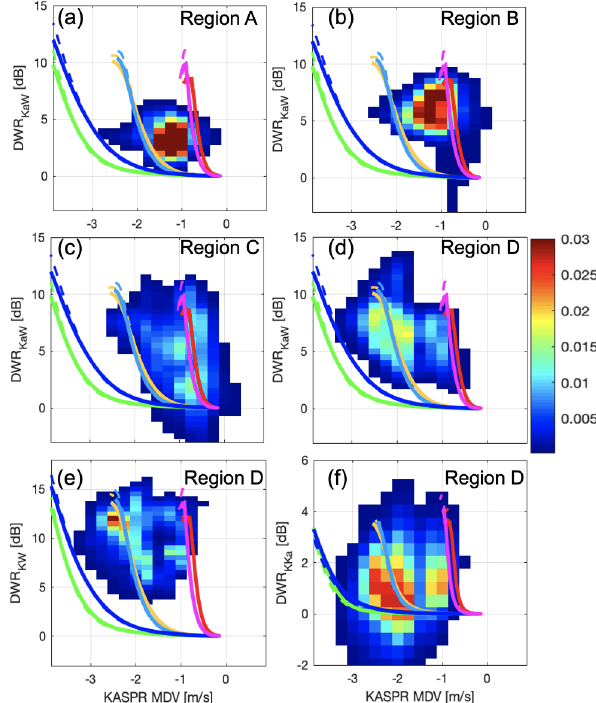
Figure 8. (a) – (d) Diagrams of KASPR VPT MDV versus DWR KaW for regions A, B, C, and D, respectively. (e) Diagram of KASPR VPT MDV versus DWR KW for Region D and (f) of KASPR VPT MDV versus DWR KKa for Region D. Color shades represent normalized frequency. Lines in each panel represent the SSRGA calculations using different particle models and PSDs de- scribed in Appendix A. The legend for the lines is as in Fig.